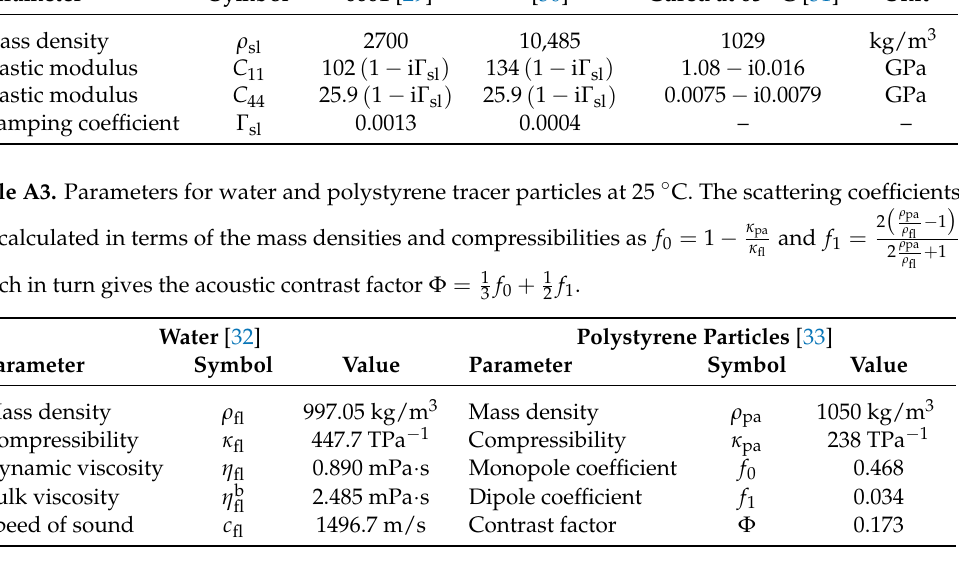
Table A2. Parameters used in the linear-elastics modeling of aluminum, silver, and PDMS.